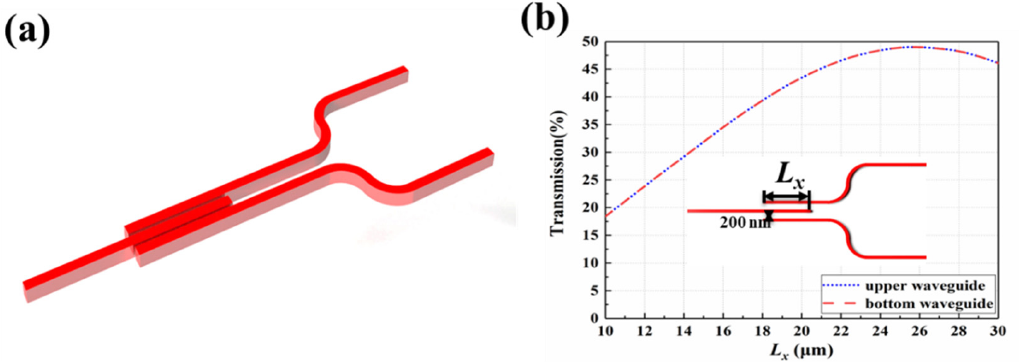
Figure 8. ( a ) The structure of 3-dB coupler. ( b ) The relationship between coupling length ( L x ) and transmission.